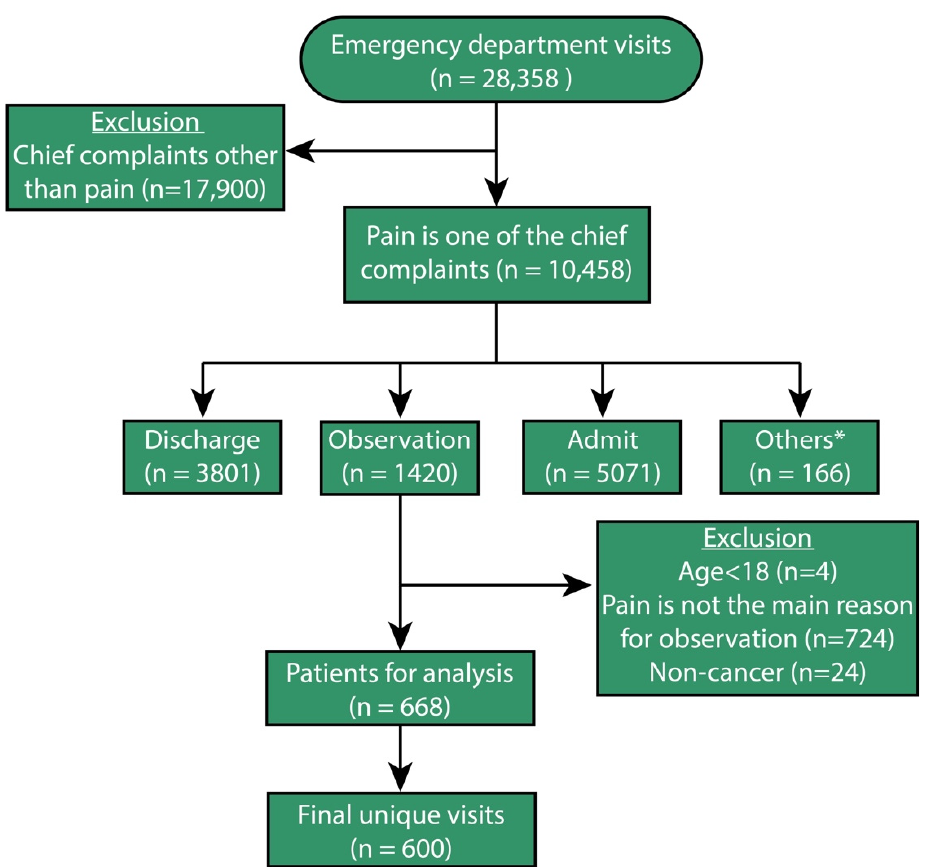
Figure 1. Flow diagram showing the patient selection steps. * Including patients who passed away, who were transferred, and who left against medical advice.